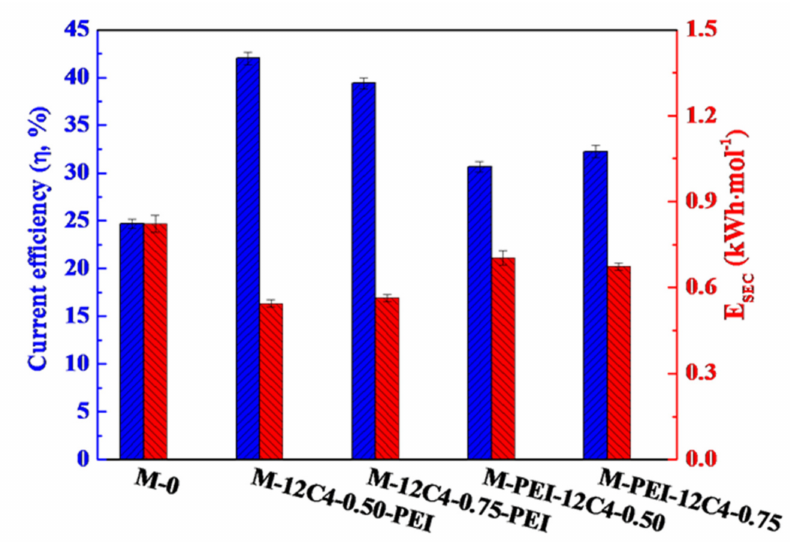
Figure 12. Current efficiency ( η ) and energy consumption (E SEC ) of the pristine (M-0) and modified (M-12C4-x-PEI, M-PEI-12C4-x, x = 0.50 and 0.75) membranes in 0.05 M binary mixture of LiCl and MgCl 2 at a current density of 5.0 mA · cm − 2